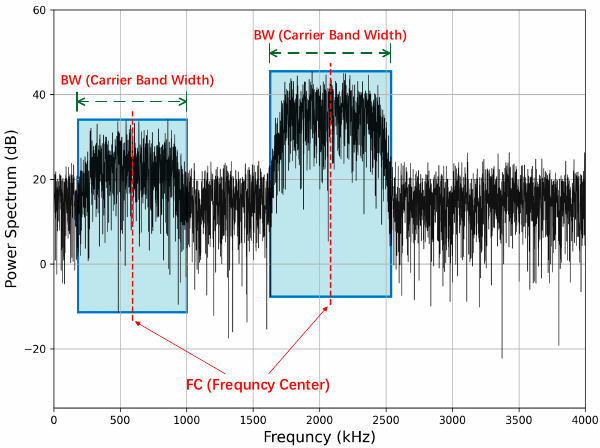
Figure 1. The core task of carrier signal detection problem in the broadband power